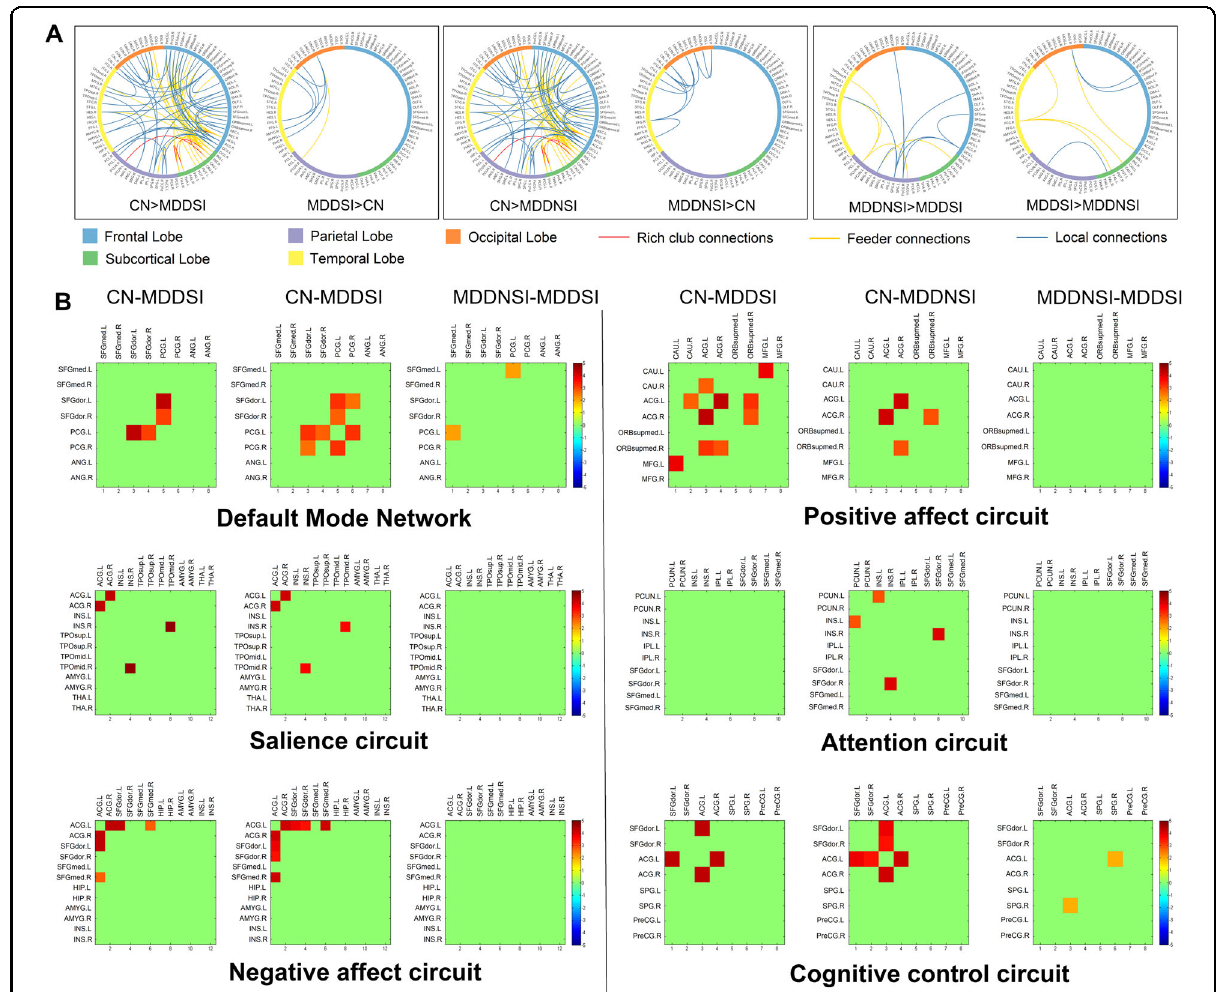
Fig. 3 Differential edges of structural subnetworks and the distribution of six related-depression network modules. A Differential edges of structural network using the network-based statistic (NBS) method (edge P = 0.01, component P = 0.1, iteration = 1000) among the three groups. The brain regions are indicated as a circle. The rich club connections (red lines), the feeder connections (yellow lines), and local connections (blue lines) are connected by lines. B The differential connection strengths are put into six related-depression network modules. Each small block represents a differential edge of a region connected another region, and the color of the block represents the T value of the corresponding the differential edge. CN, cognitively normal; MDDSI, major depression disorder with suicidal ideation; MDDNSI, major depression disorder with non- suicidal